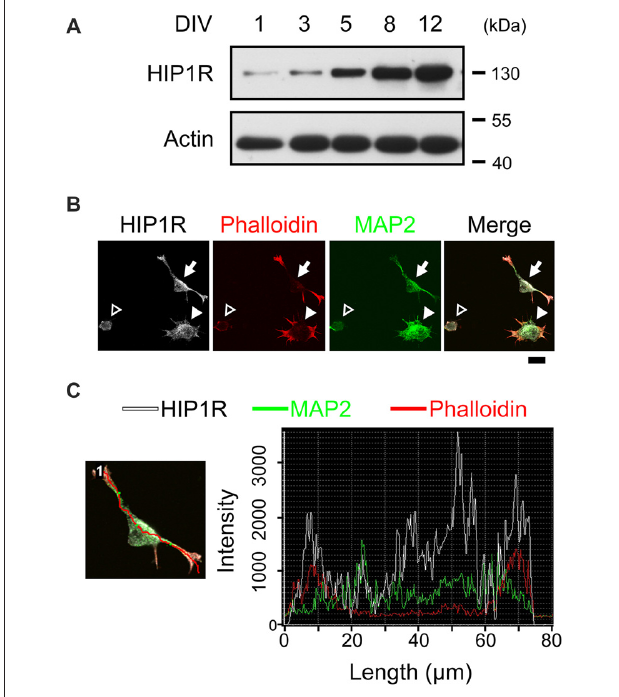
FIGURE 1 | Huntington-interacting protein 1-related protein (HIP1R) co-localizes with actin during neurite initiation. (A) Expression of HIP1R in cultured hippocampal neurons at different time points. (B) Representative images of HIP1R expression in cultured hippocampal neurons. HIP1R (gray), phalloidin (red) and MAP2 (green). Open arrowhead, neurite initiation stage 1a; filled arrowhead, stage 1b; filled arrow, stage 2. Scale bar, 10 µ m. (C) Representative analysis of fluorescence intensity distributions of HIP1R and F-actin in neuron. Line scan method was used to detect the intensities of fluorescent signals (right panel) along the red line in the example neuron (left